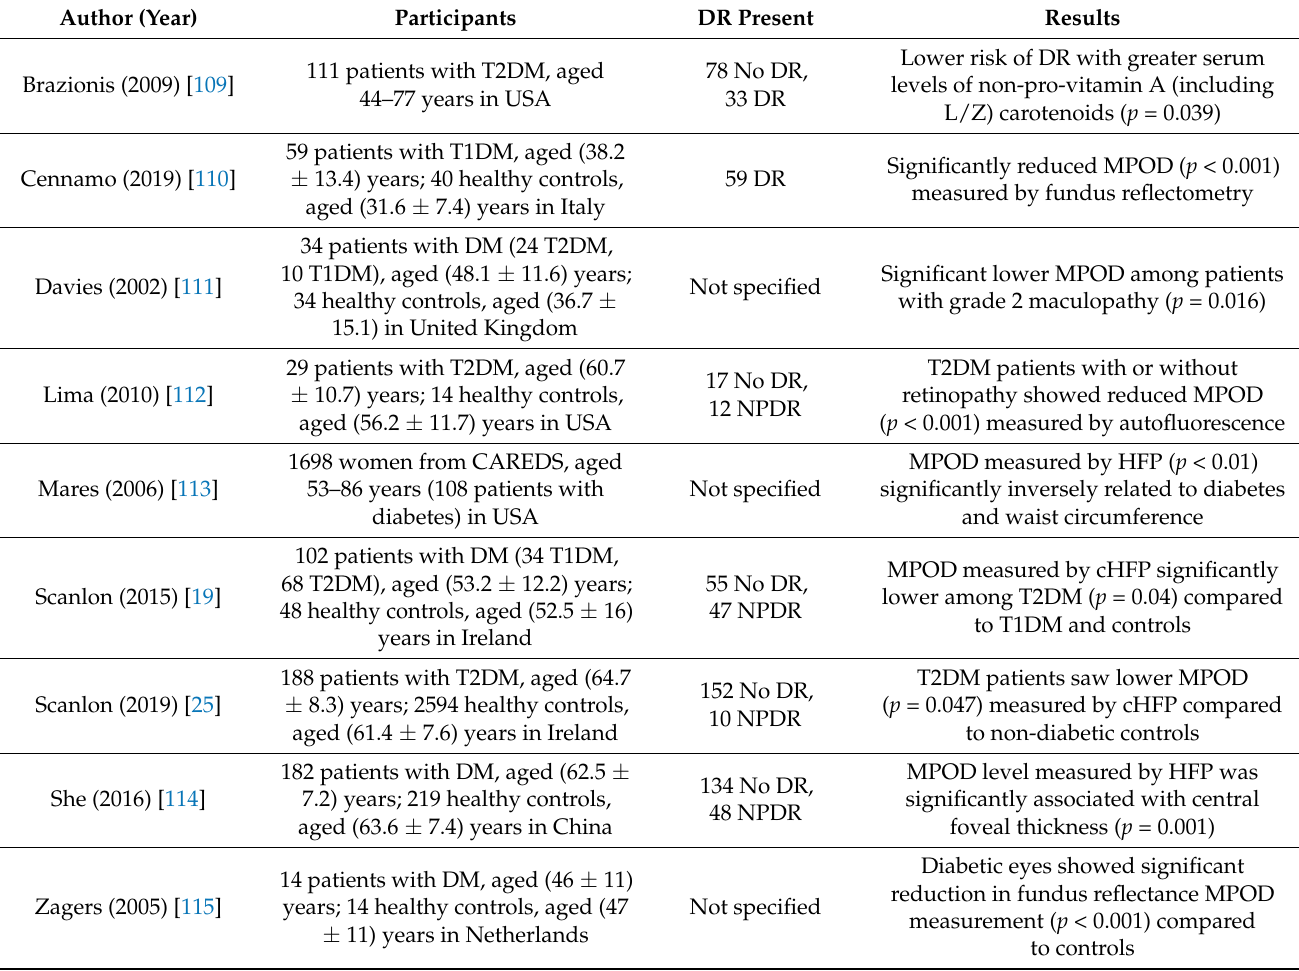
Table 3. A summary of the observational